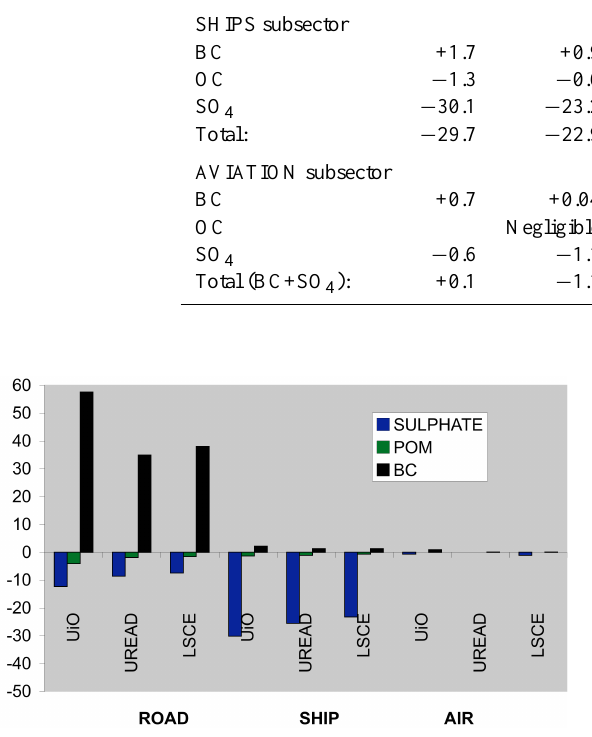
Fig. 5. Comparison of the all-sky total direct aerosol global-mean Figure 5. radiative forcings (mWm − 2 ) for the three sub-sectors. For all three models, the BC aerosols are considered internally